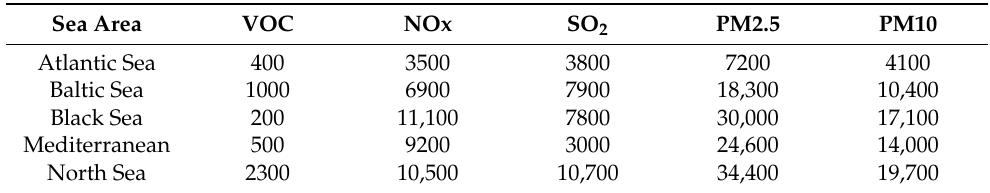
Table 5. Estimation of annual average social environmental cost 1 for air pollution from ships in European sea areas [EUR 2016 /ton].